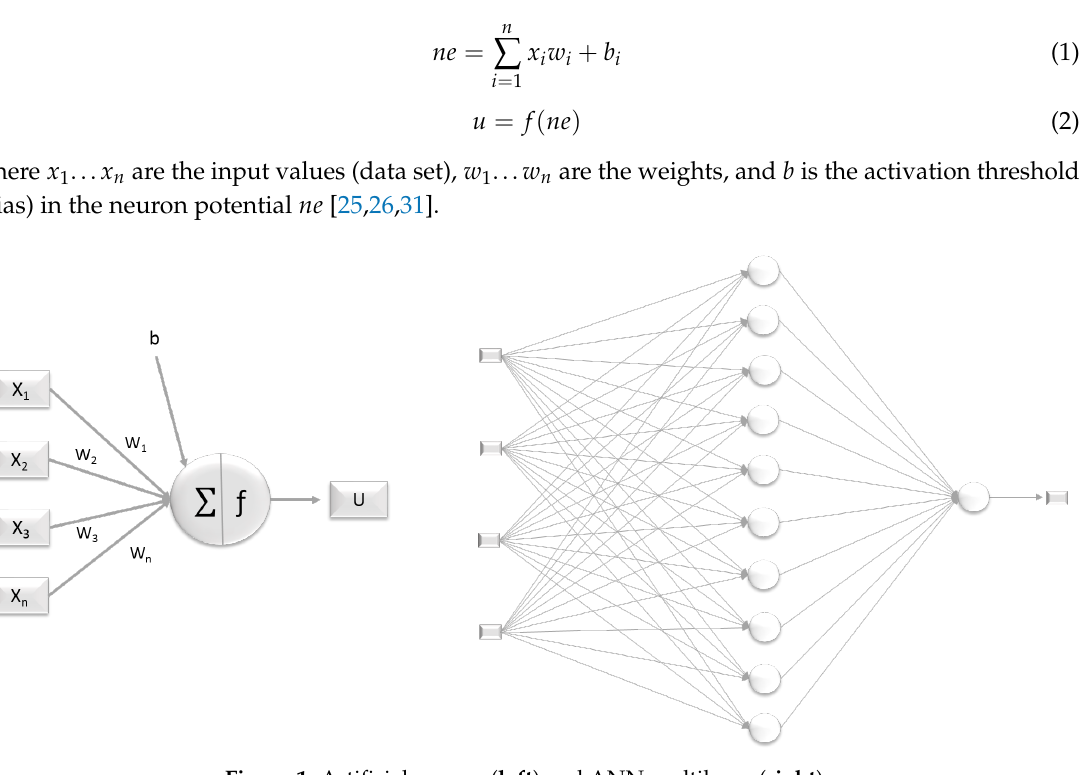
Figure 1. Artificial neuron ( left ) and ANN multilayer ( right